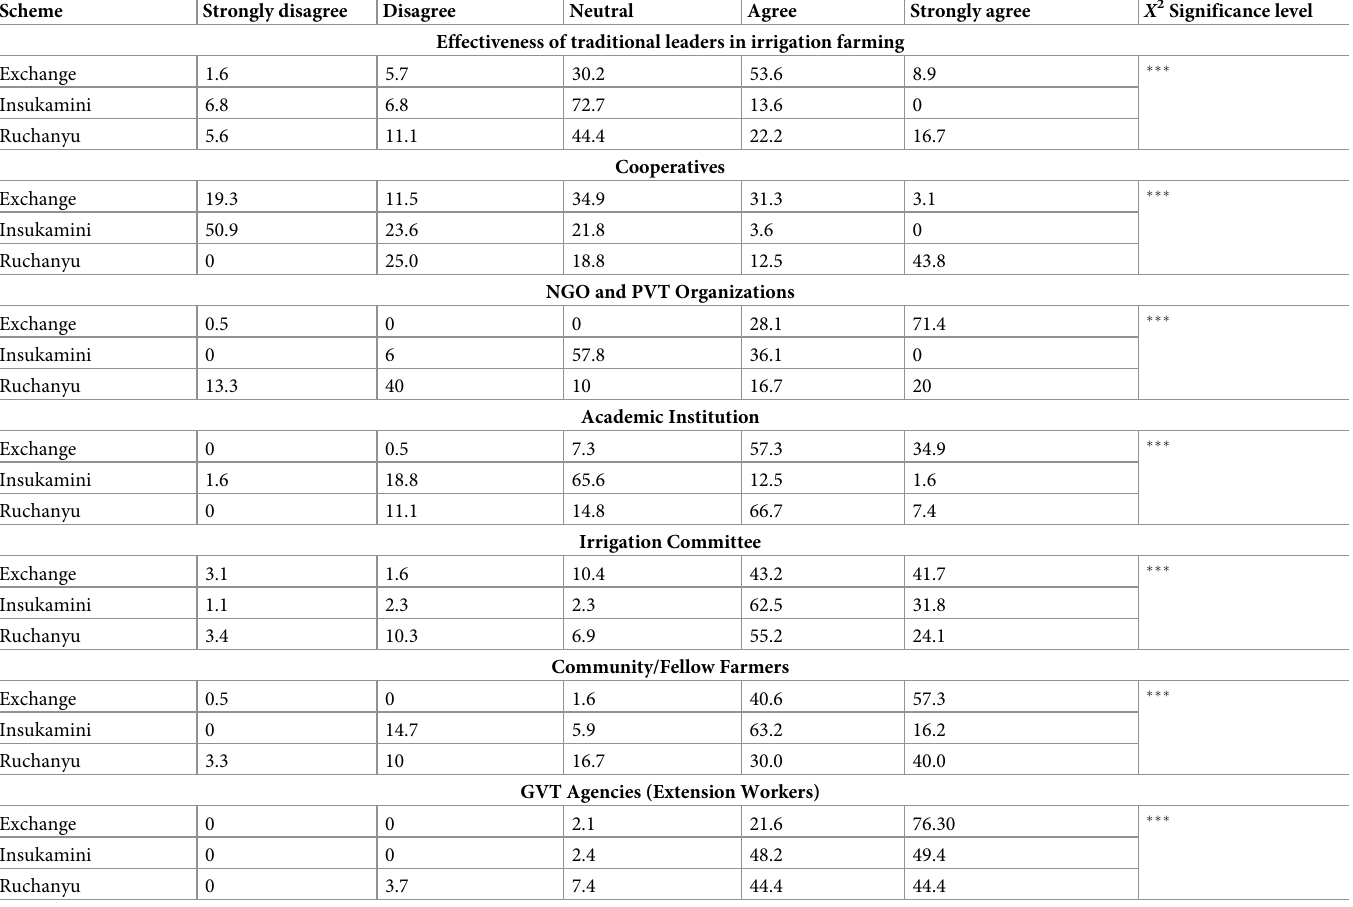
Table 4. Institutional factors of Exchange, Insukamini and Ruchanyu irrigation schemes.